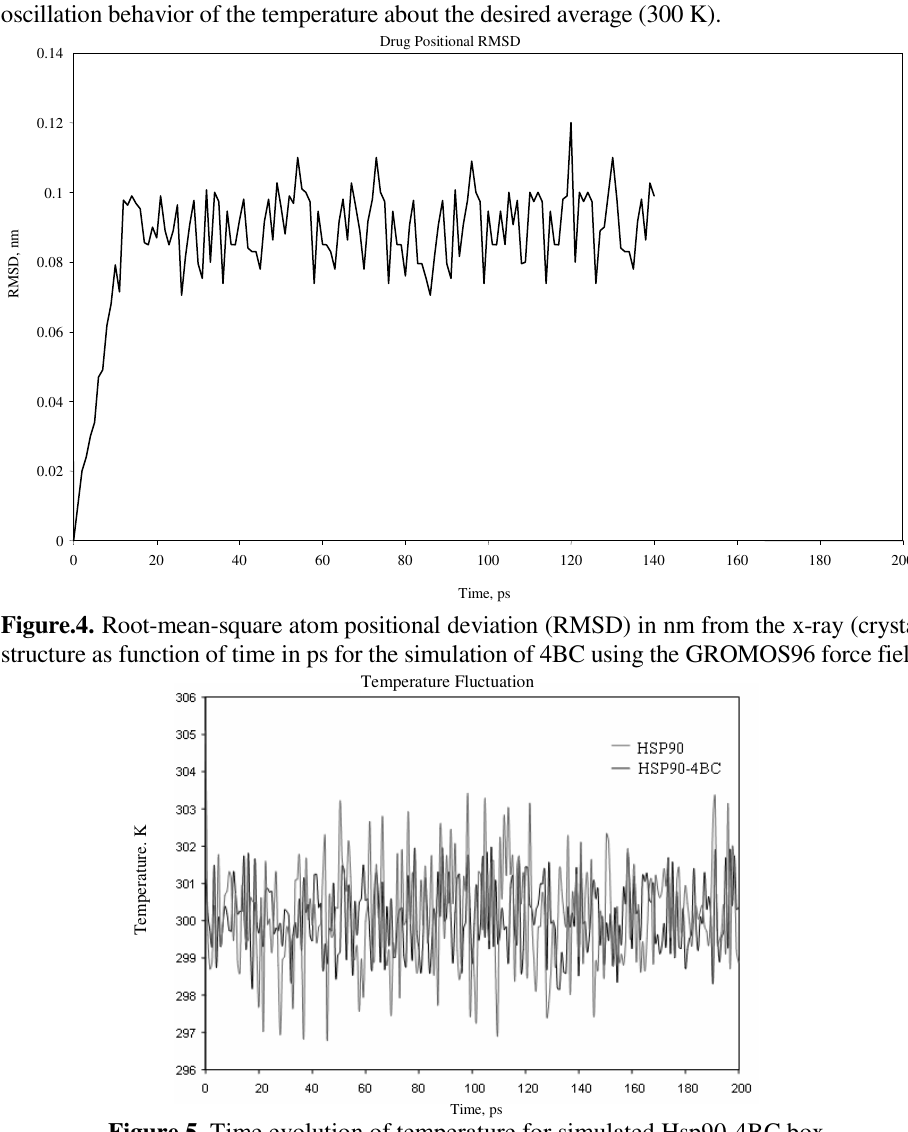
Figure 5. Time evolution of temperature for simulated Hsp90-4BC